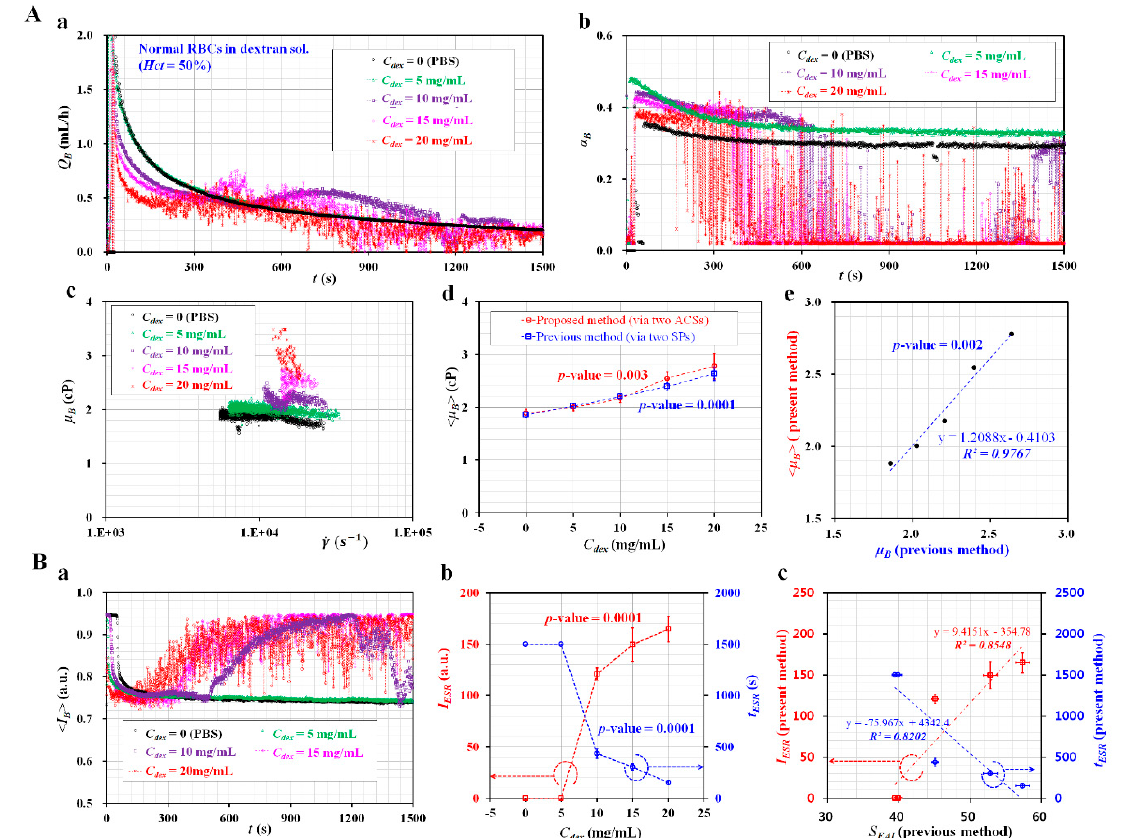
Figure 6. Measurement of blood viscosity and ESR for blood samples composed of specific concentrations of dextran solution. Blood samples ( Hct = 50%) were prepared by adding normal RBCs into various concentration of dextran solution ( C dex ) (i.e., C dex = 0, 5, 10, 15, and 20 mg / mL). C dex = 0 meant 1 × PBS as control. ( A ) Variations of blood viscosity with respect to C dex . ( a ) Temporal variations of Q B with respect to C dex . ( b ) Temporal variations of α B with respect to C dex . ( c ) Variations of µ B with respect to shear rate and C dex . ( d ) Variations of < µ B > with respect to the C dex and fluid delivery system (ACS, SP). ( e ) Correlation between blood viscosity obtained by the proposed method and blood viscosity obtained by the previous method. ( B ) Variations of ESR with respect to C dex . ( a ) Temporal variations of < I B > with respect to C dex . ( b ) Variations of two ESR indices ( t ESR , I ESR ) with respect to C dex . ( c ) Quantitative comparison between the proposed method ( t ESR , I ESR ) and previous method ( S EAI ).